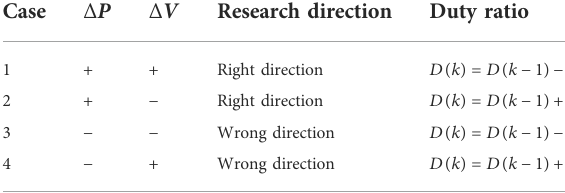
TABLE 3 MPP search